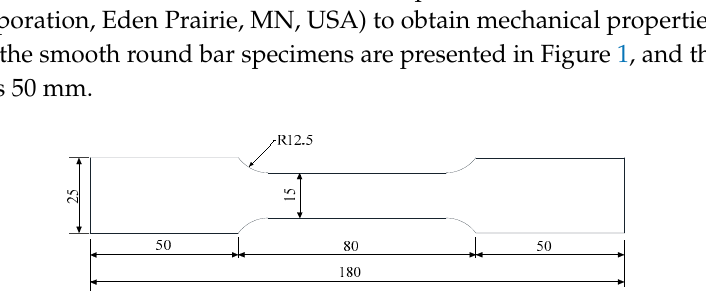
Figure 1. Dimensions of smooth round bar specimens (unit: mm).